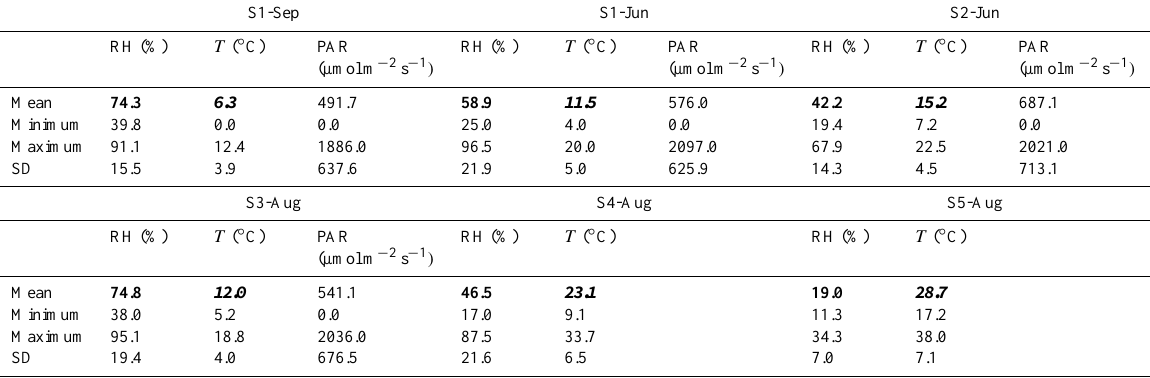
Table 2. Meteorological data at each site during the observation periods. Note: S1-Sep, S1-Jun, S2-Jun and S3-Aug indicate the 2900m Qinghai spruce forest site in September 2011, the 2900m site in June 2011, the 2700m site in June 2011 and the 2800m site in August 2009 in the upper reaches. S4-Aug and S5-Aug indicate the riparian forest at 930m and the Gobi site at 906m in August 2009 in the lower reaches. S1-Sep